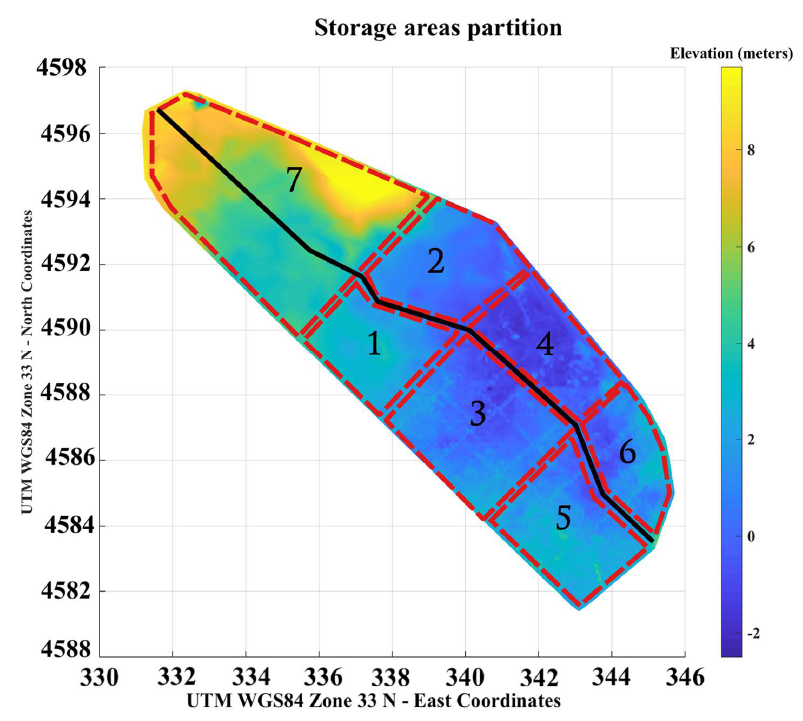
Figure 6. Storage areas partition of the Mazzocchio basin.